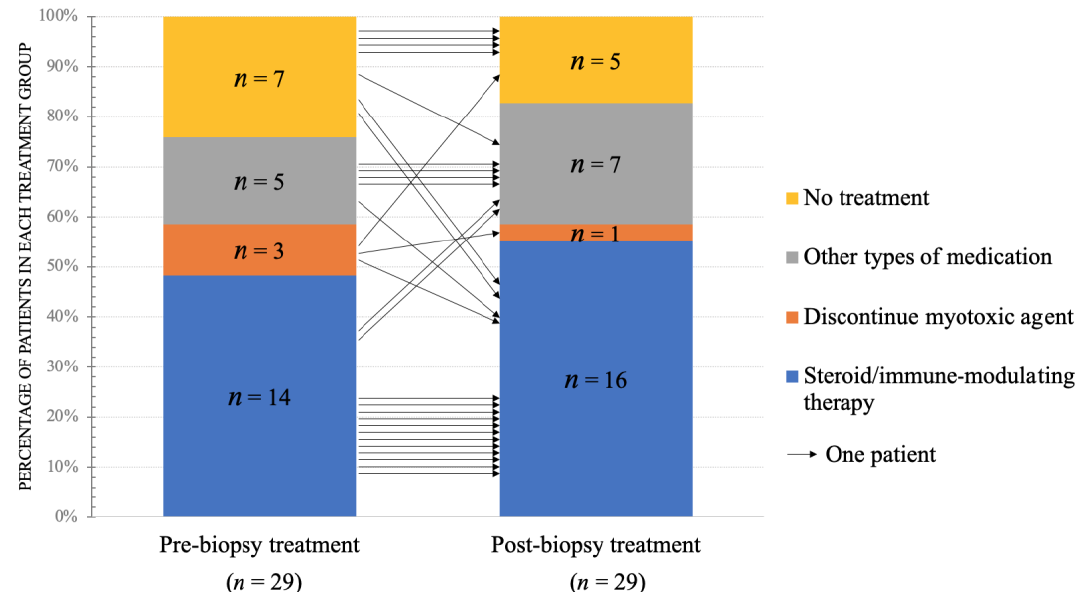
Figure 3. Comparison of pre- and post-biopsy clinical treatment in the group with change. A total number of 29 patients in the group with change was demonstrated. The vertical axis represented the percentage of patients in each treatment group. Each arrow represented one patient and showed the corresponding change of treatment after muscle biopsy. n , number of patients. Table 3. A list of patients who had both diagnosis and treatment changed after muscle biopsy.